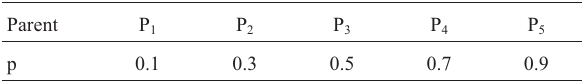
Table 1 - Favorable allele frequencies (p) for the five parents (Pi, where i = 1, 2, ...5). Parent P 1 P 2